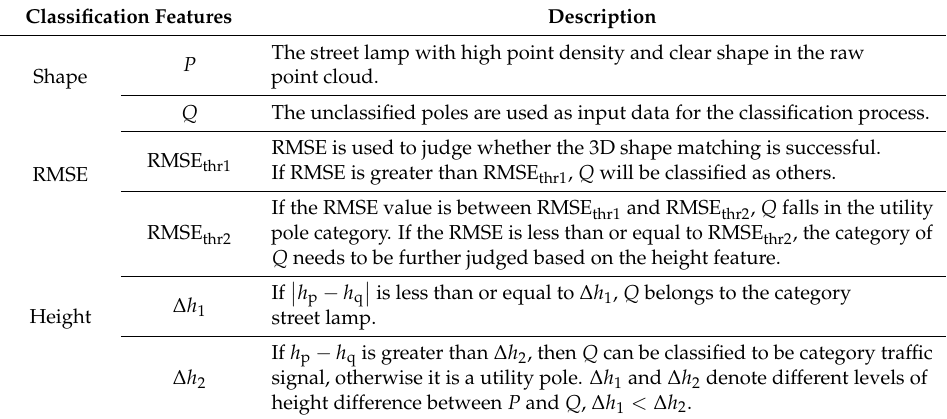
Table 2. Features used in the process of classification.